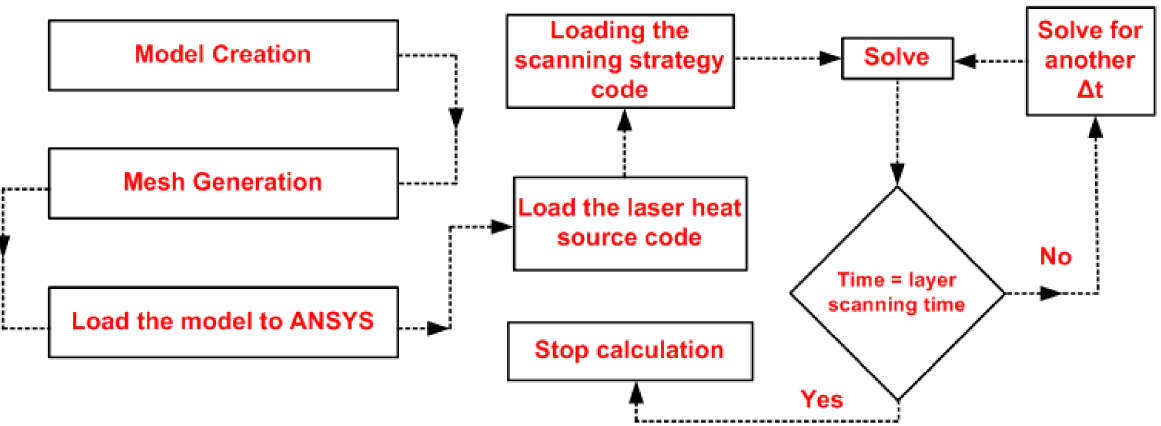
Figure 4. Flowchart of the model solution